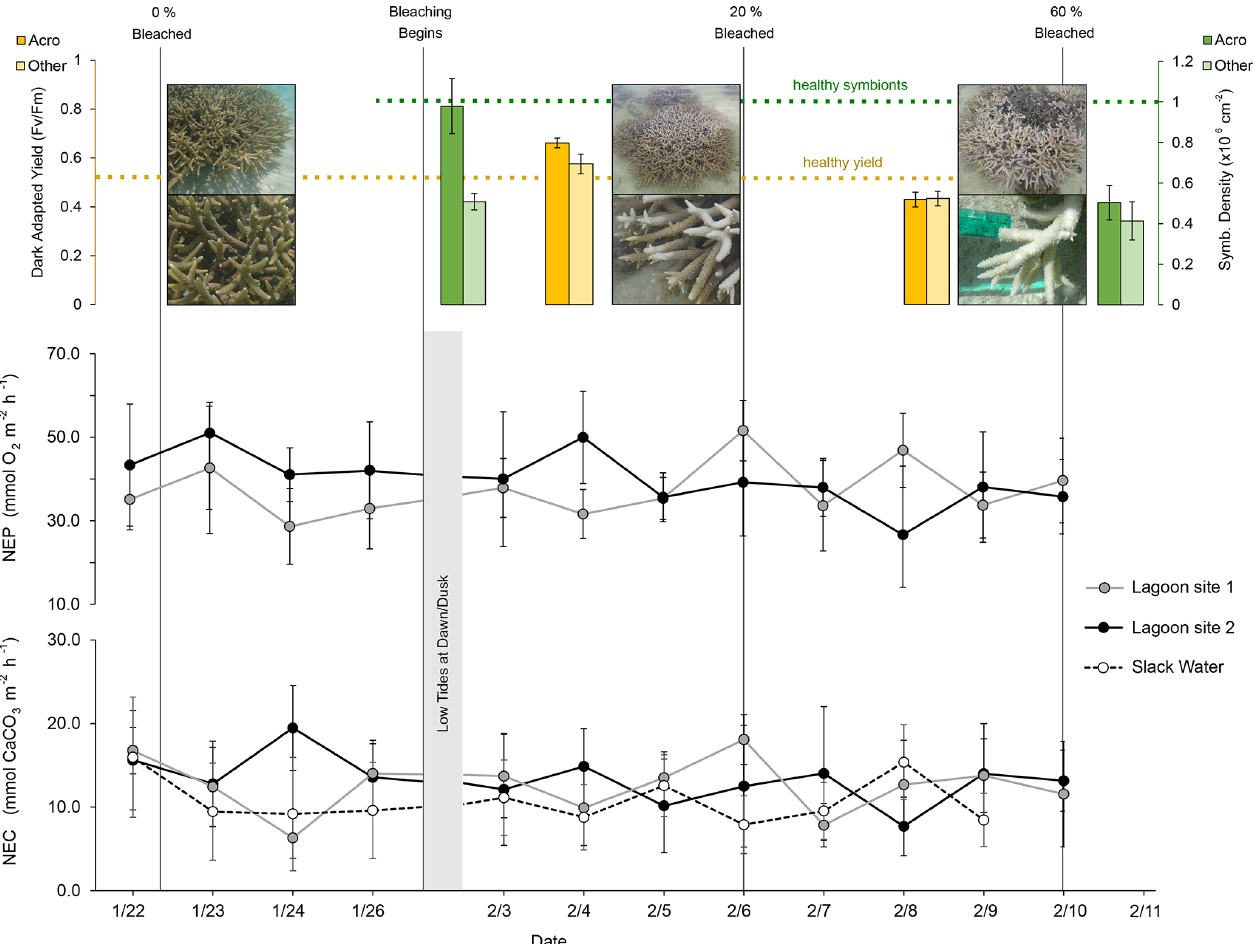
Figure 3. Dark-adapted yield (yellow; top left), Symbiodiniaceae densities (green; top right), rates of net ecosystem production (NEP; mid- dle), and net ecosystem calcification (NEC; bottom) at lagoon site 1 (gray), lagoon site 2 (black), and the larger reef area (dashed; slack water). Dashed yellow and green lines indicate expected healthy values for dark-adapted yield and Symbiodiniaceae densities, respectively. Vertical gray lines indicate the date of photo-quadrat surveys and the resulting percent area of coral that was bleached. NEP and NEC estimates were paused between 26 January and 3 February due to low tides occurring at dawn and dusk in low light conditions, preventing estimates of NEC. Slack-water estimates are excluded from the NEP data given the large error associated with air–sea gas exchange